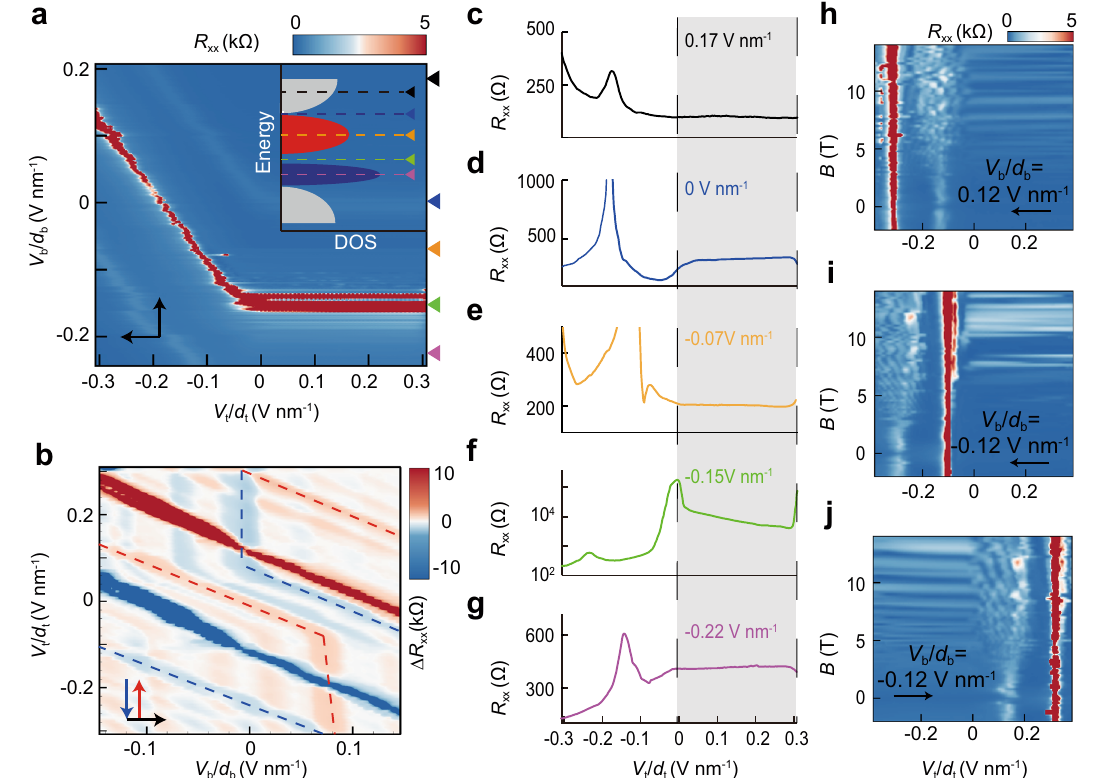
Fig. 2 | Ferroelectricity and anomalous screening in magnetic fi elds. a The anomalous screening) indeed exists in electronic states with Fermi surfaces higher than the electron moiré band c , at FFP d , within the electron moiré band e , at CNP anomalousscreeningatCNPandFFPishighlightedina V t - V b phasediagram,where fi ve linecuts are denoted by colored triangles. Inset: Their correspondences in the f ,andwithintheholemoiréband g .Importantly,theseanomalouscurvesspanover almost the same V t regimes highlighted by the grey shadow, despite their distinct band structure. b In perpendicular magnetic fi elds (10T), anomalous screening displacement fi elds. h – j Landau fans are characterized by three typical electronic behavior and the associated hysteresis loops become visible in many more elec- states, whose Fermi surfaces (when the anomalous screening occurs) are above tronic states, two of which are highlighted by the dashed curves. This is due to h and within i the electron moiré band, and below the hole moiré band prominent Landau levels that enhance the visibility of low-resistance states. j , c – g Carefulexaminationrevealsthat,a fl atresistancecurveindependenton V t ( i.e ., V − 0.2 to 0.2 Vnm − 1 . Throughout the manuscript, b step by step from the fast-scan gate is plotted in the x axis and the slow one in the y axis; thescanningdirectionsaredenotedbyarrowsineachgraph.Asshown in Fig. 1d, striking hysteresis (and anomalous screening manifested as horizontal ridges) are observed at both CNP (red) and two FFP (white).